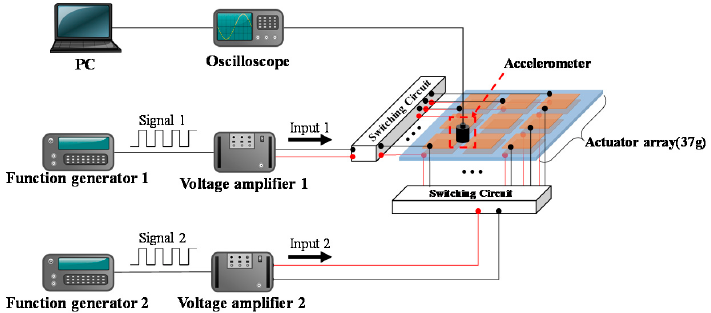
Figure 7. Experimental environment to measure the vibrational acceleration of the actuator array.